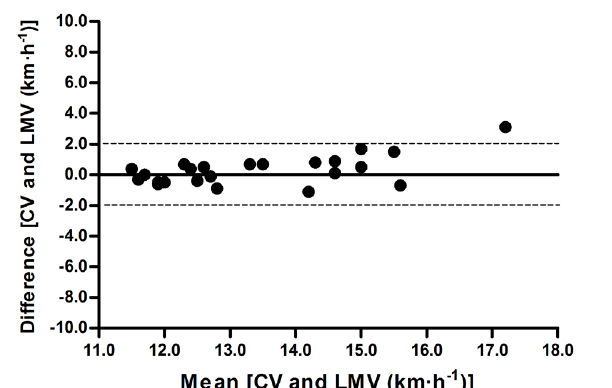
Figure 3. Bland and Altman analysis between critical velocity (CV) and lactate minimum velocity (LMV).